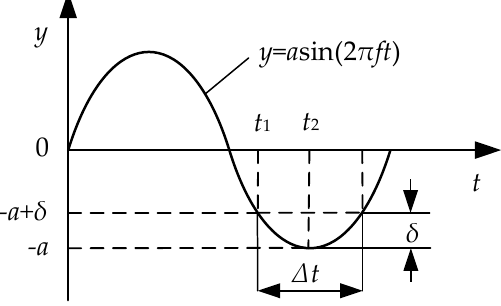
∆ t in an ultrasonic vibration Figure 3. The distribution of t  in an ultrasonic vibration period. Figure 3. The distribution of